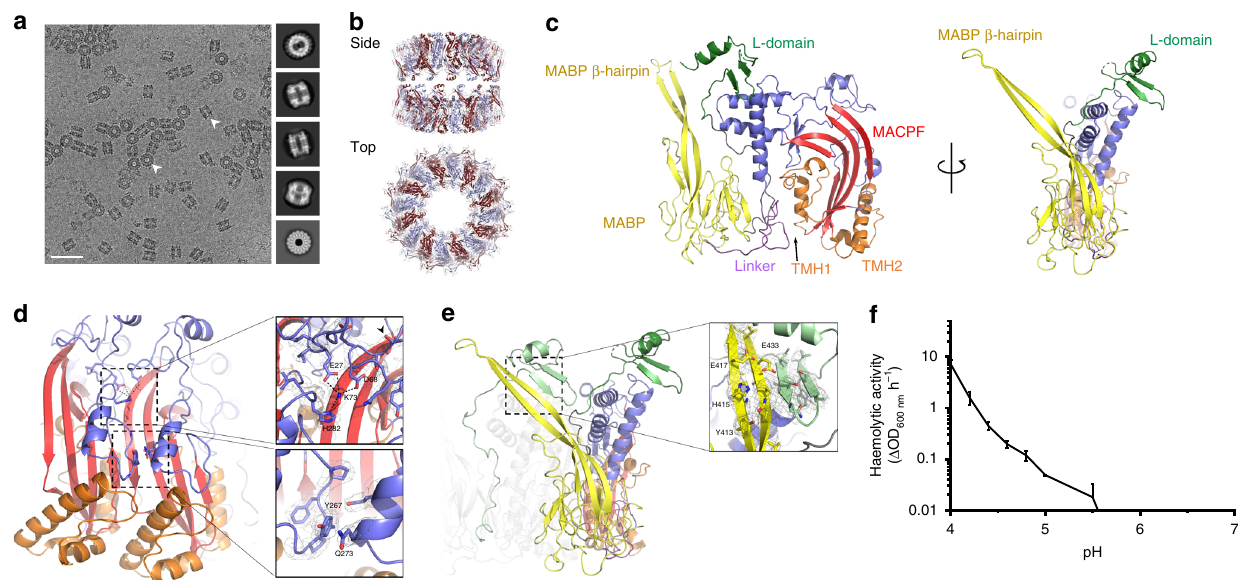
Fig. 1 Cryo-EM of MPEG1 soluble prepores. a Representative image of MPEG1 together with a selection of class averages are shown (scale bar: 50 nm). b 2.4 Å structure of the MPEG1 assembly; two hexadecameric rings (monomers alternately coloured) stack together to form a head-to-head dimer. c Two views of the MPEG1 monomer are shown (side on (left) and the C-terminal region (foreground) viewed from peripheral region of assembly (right)). The MACPF/CDC domain is in blue, with the central sheet in red, and TMH-1/2 in orange. The central globular domain (MABP domain) is in yellow, and the L- domain is in green. d Interactions made in the lumen, around the central β -sheet. Residue T56 is indicated by an arrow. e Interactions made in trans by the MABP β -hairpin (yellow) with the L-domain (green). f Lytic activity of the prepore material at a range of different pH (min. to max. box limits, error bars represent SE, n = 4. Error is plotted for all points). Source data are provided as a Source Data fi